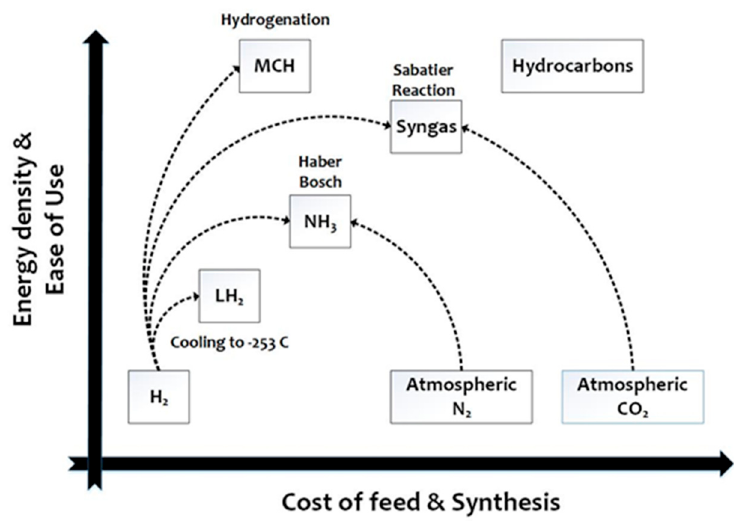
Figure 2. Hydrogen carriers based on energy density and synthesis cost (adapted from [35]).